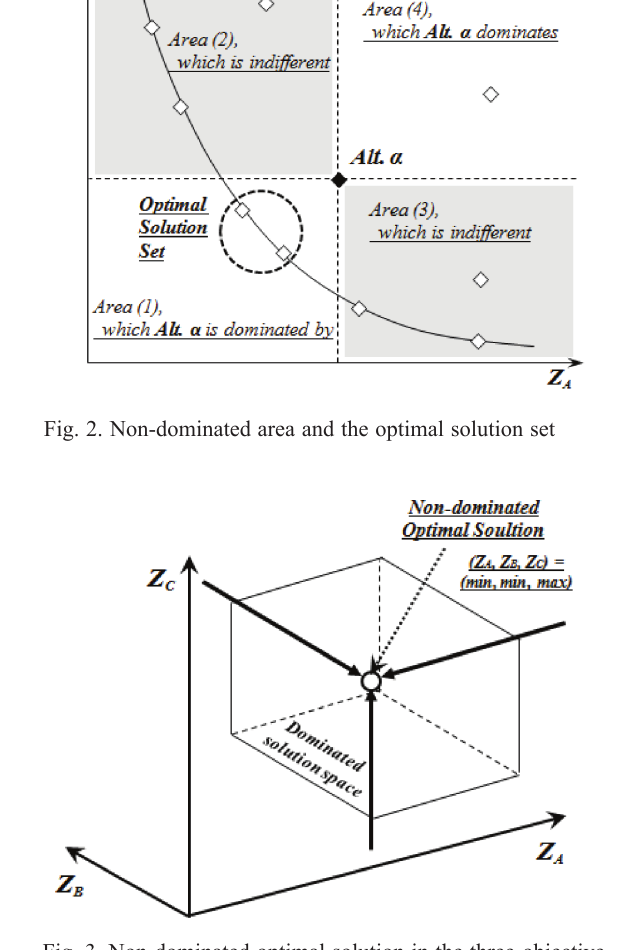
Fig. 3. Non-dominated optimal solution in the three-objective